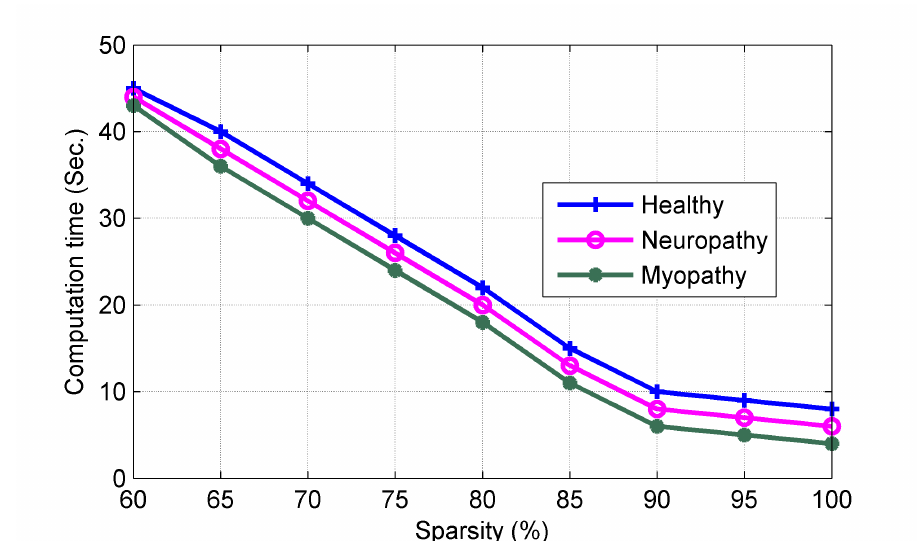
Figure 7. Computation